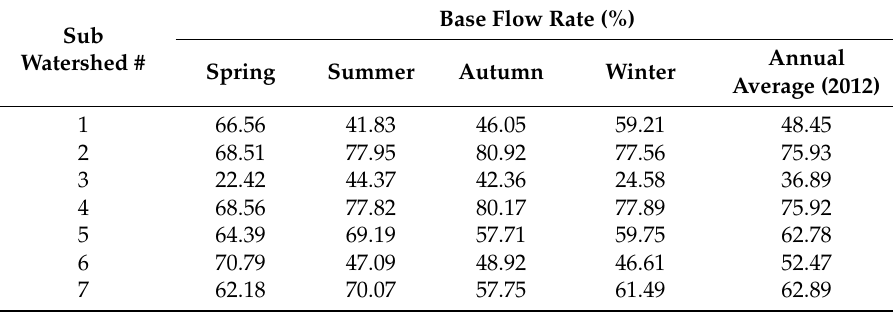
Table 7. Seasonal and annual average base flow rates for WSG